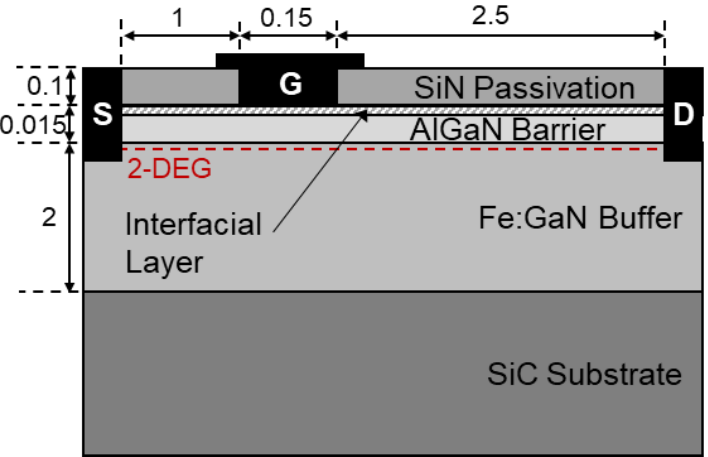
Figure 1. Schematic cross-section of the DUTs. 2-DEG stands for two-dimensional electron gas. A narrow (2 nm) interface layer between the passivation and AlGaN barrier was introduced in the simulations to reproduce experimental results, as discussed in more detail in Section 4. Reported dimensions are in μm (not to scale).